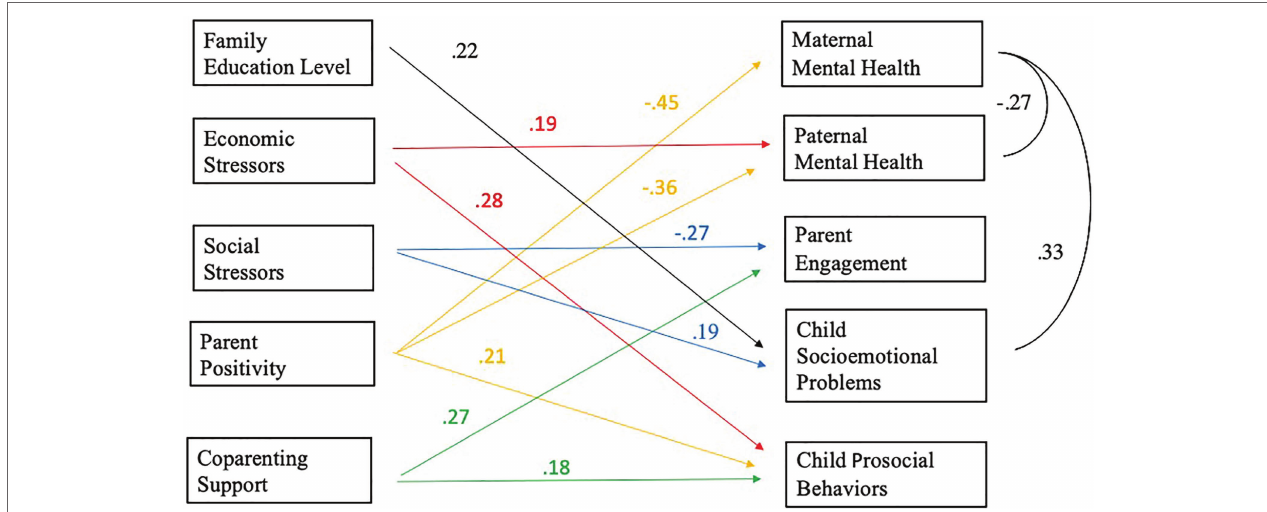
FIGURE 1 | The roles of Economic stressors, Social stressors, Parent positivity, and Coparenting support on maternal and paternal mental health, Parent engagement, Child socioemotional problems and Child prosocial behavior controlling for family education level. Note . All predictors are mean-centered. For parsimony, errors and non-significant coefficients are omitted from the figure. All standardized coefficients and covariances are significant at p < 0.05. Significant paths are color-labeled based on the predictors.